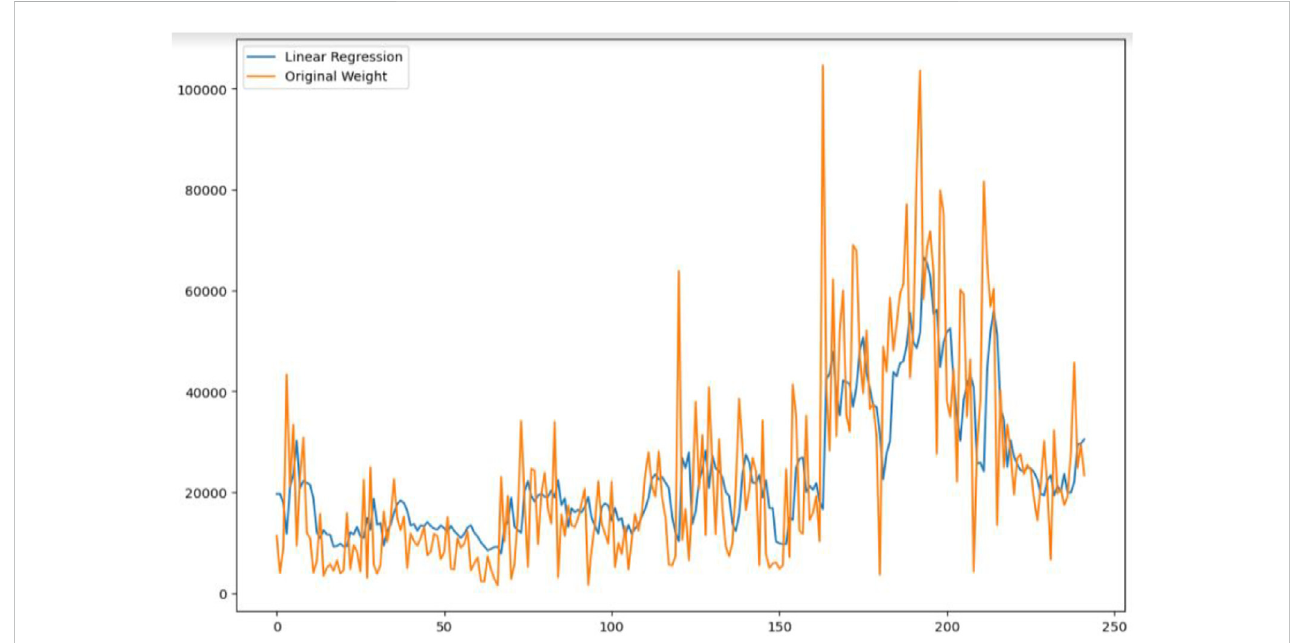
FIGURE 10 Model training with linear regression to predict the behavior of the beach waste generation.